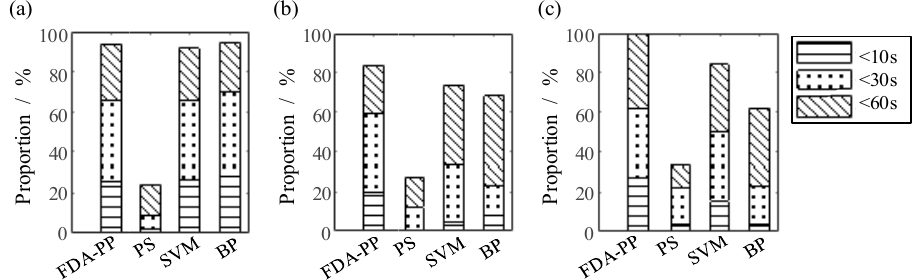
Figure 8. Absolute deviation of the predicted end-point time on ( a ) the normal batches, ( b ) the splashing batches, ( c ) the drying batches. splashing batches, ( c ) the drying